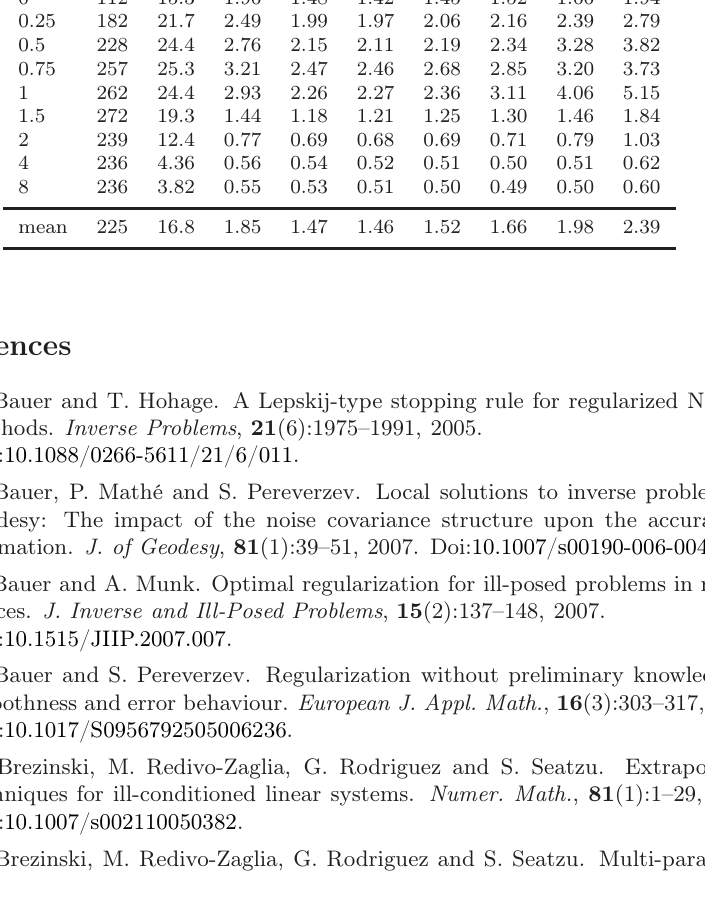
Table 11. Means of error ratios for v